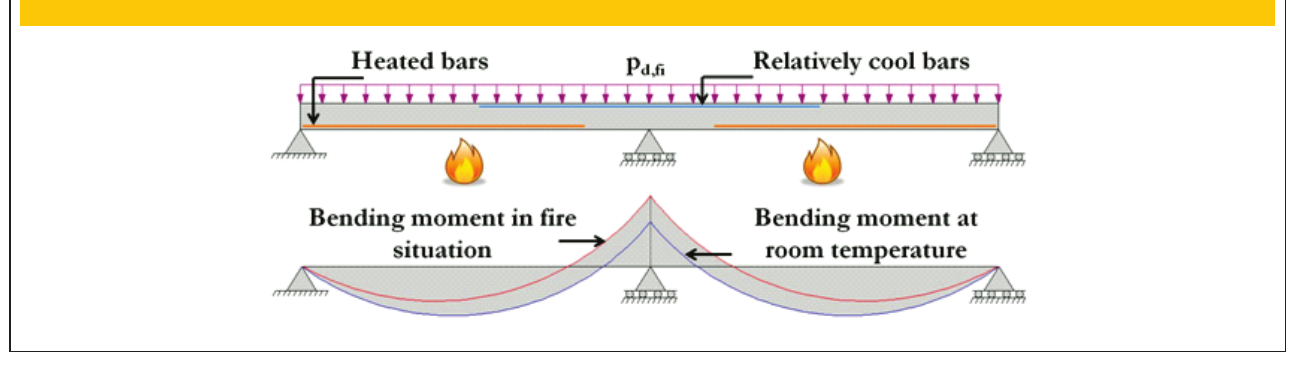
Figure 9 – Redistribution of applied moments in a continuous beam exposed to fire